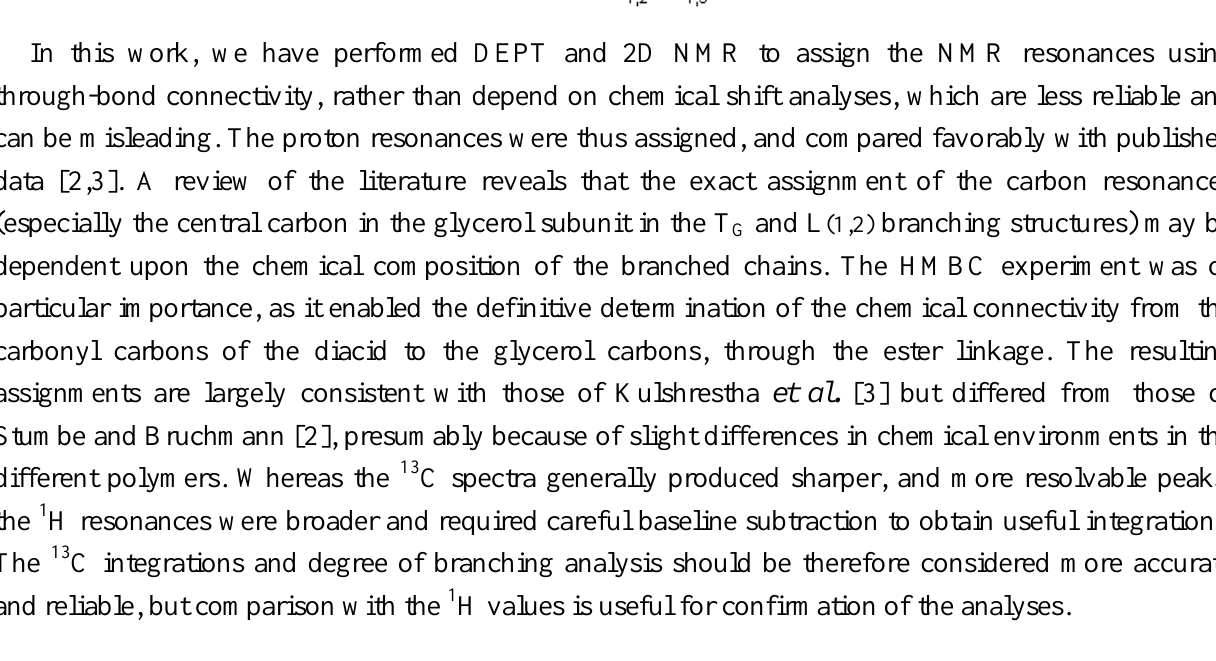
Figure 2. The 2D-HMQC of the succinic acid:glycerol polymer (1:1 molar ratio, 110 °C).